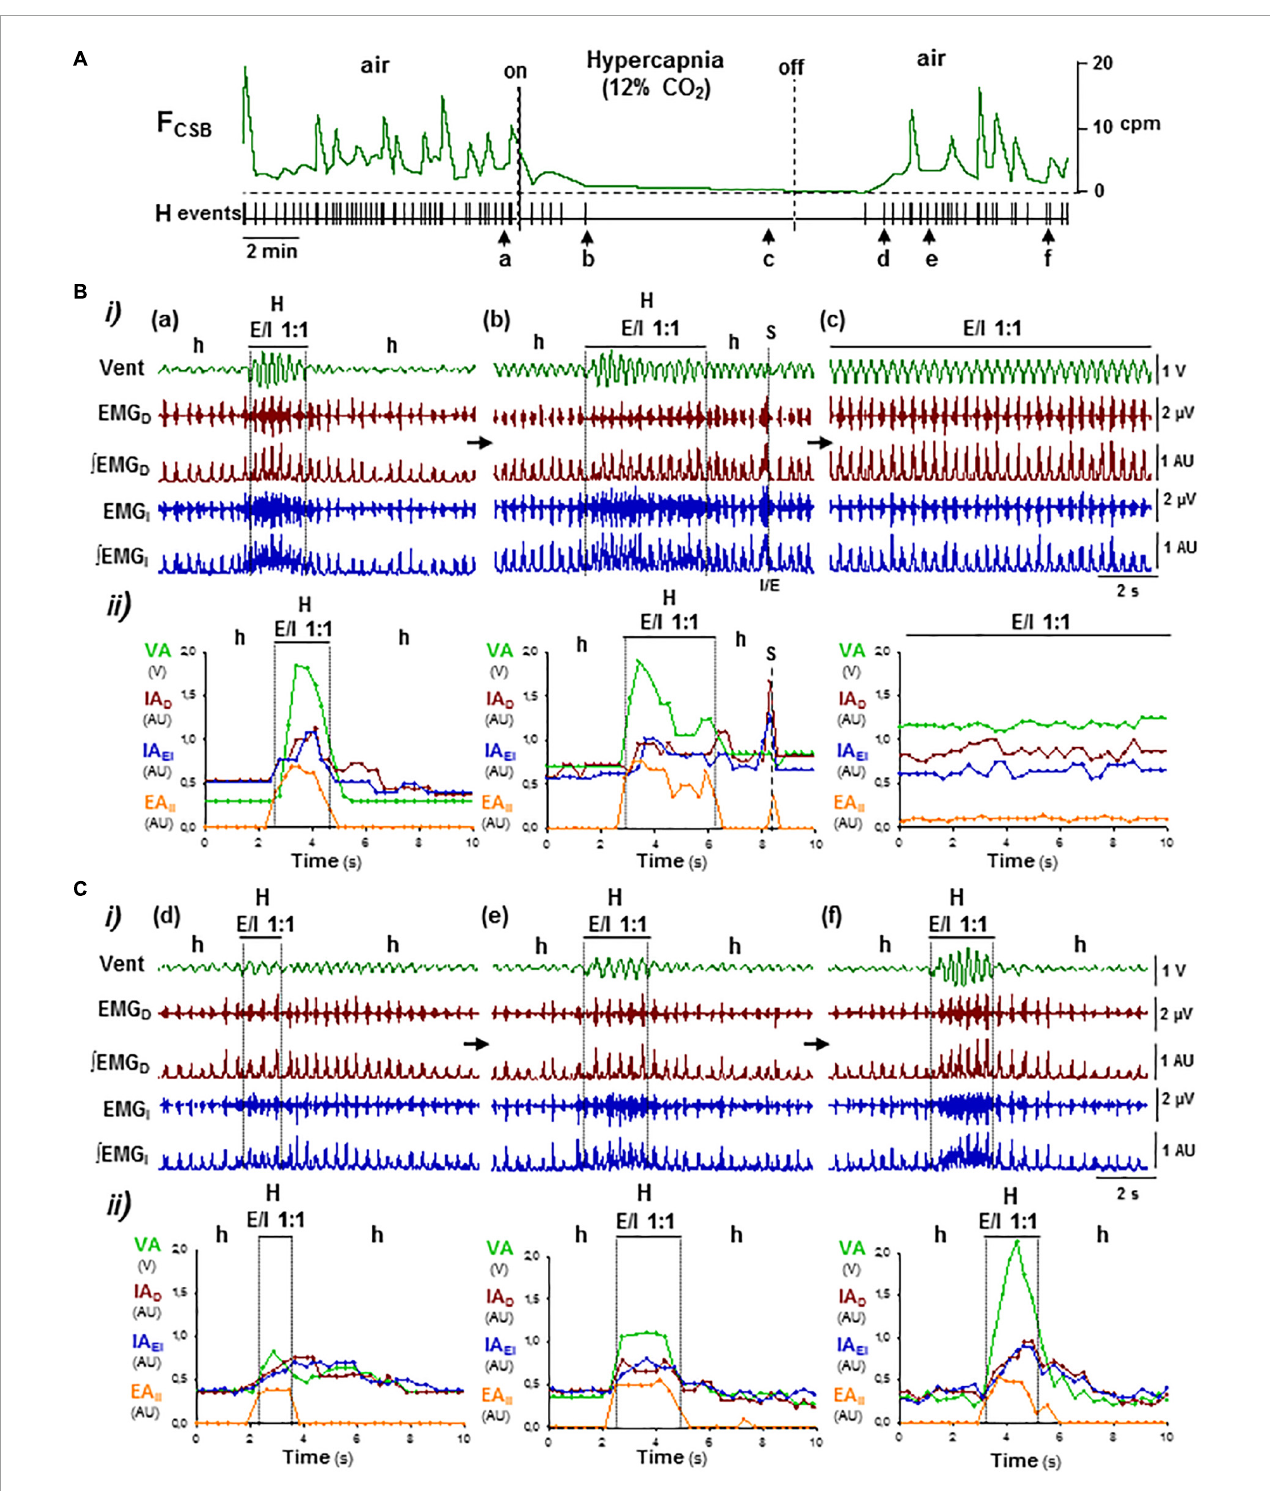
FIGURE5 OFF/ON reconfigurations of CSB motor pattern induced by hypercapnia–normoxia. (A) Supplemental administration of CO 2 and its removal in inhaled air of Cx36KO mice (12% CO 2 in normoxia) suppressed reversibly CSB ( on/off ); F CSB , oscillatory frequency of CSB and HP , point process of hyperpnea epochs. Arrows (a–f) , changes in the respiratory pattern shown in (B,C) . (B,C) Off and on reconfigurations of the respiratory motor pattern leading to suppression ( a–c in B ) and reboot of CSB ( d–f in C ). (i) Vent , ventilatory motion; EMG D , R EMG D , EMG I , and R EMG I , raw and rectified inspiratory and expiratory activities of the diaphragm ( D ) and external and internal intercostals ( EI, II ), and (ii) superimposed graphs cycle-by-cycle of the ventilatory amplitude ( VA ), peak-intensity of the inspiratory diaphragm and the external intercostal ( IA D and IA EI ) and expiratory internal intercostal ( EA II ) activities versus. time; h/a and H , hypopnea/apnea and hyperpnea epochs; S , sigh. High CO 2 regularized breathing by turning the expiratory–inspiratory coupling from cyclic to continuous ( E/I 1:1 , a–c ; see detail in Figure 6 ). Washout of CO 2 excess first, halted expiratory activity and depressed inspiratory activity and ventilation (c,d) and then rebooted CSB by the reactivation of expiratory activity and cyclic expiratory/inspiratory coupling (d–f)